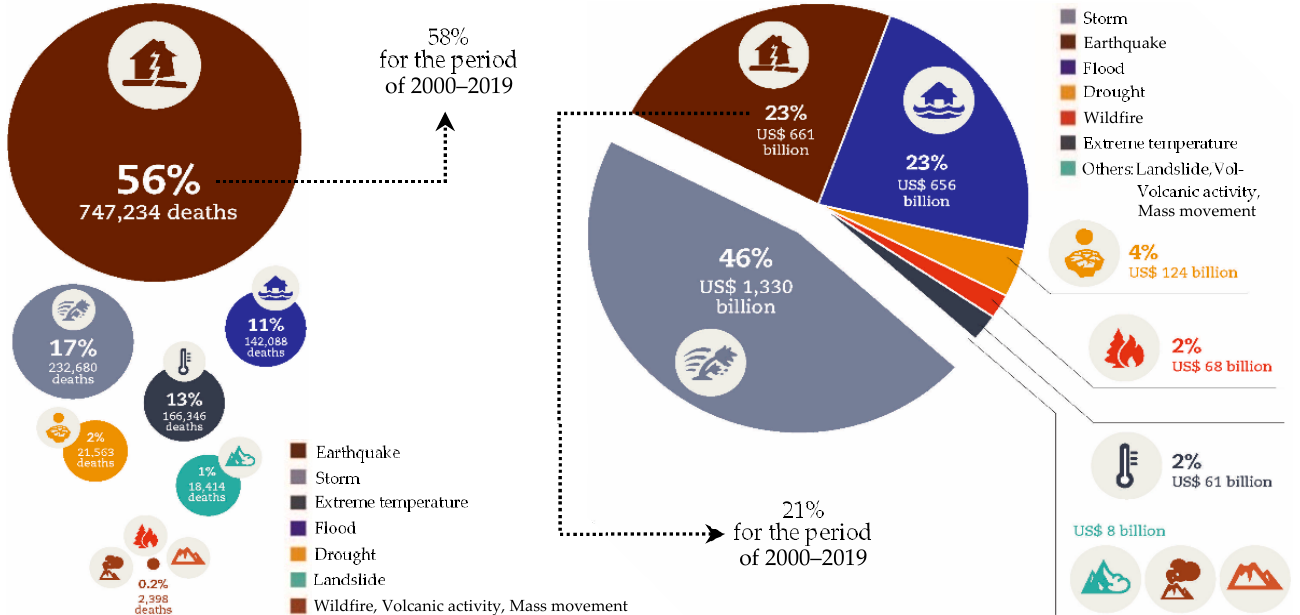
Figure 1. The continuing challenge of protection against earthquakes, indicated by comparing ( left ) the number of deaths and ( right ) the recorded economic losses due to different types of disasters occurred between 1998 and 2017 [4] together with the most recent updates for the earthquakes [3].